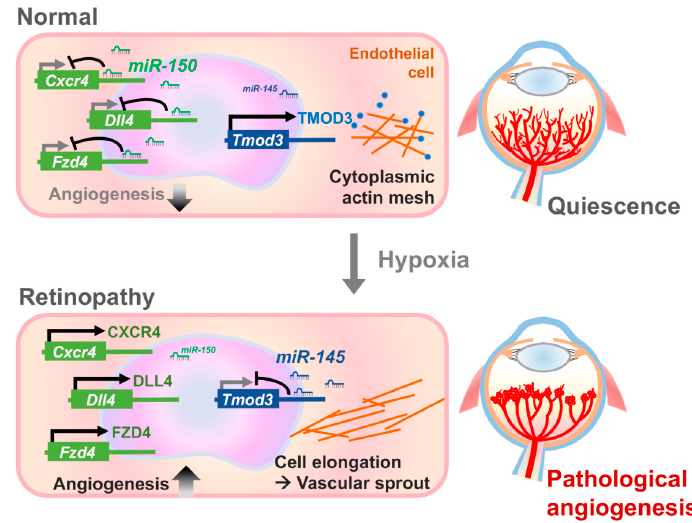
Figure 3. Targeting miR-150 and miR-145 in experimental retinopathy. This illustration uses miR-150 and miR-145 as the two examples to depict the effects of miRNAs on normal and pathological ocular angiogenesis. In normal retinal vessels, the endothelial-enriched miR-150 suppresses expression of its downstream angiogenic genes, such as Cxcr4 , Dll4, and Fzd4 , resulting in reduced angiogenic effects. On the other hand, normal endothelial cells have low levels of miR-145 , which induces target gene TMOD3, allowing its binding to the pointed end of acting filaments, stabilizing the cytoplasmic actin mesh. High levels of miR-150 and low levels of miR-145 in normal retinal vessels both function to maintain quiescence of retinal vessels. On the other hand, in retinopathy, decreased expression levels of miR-150 in pathological neovessels results in upregulation of its angiogenic targets—CXCR4, DLL4, and FZD4, leading to increased angiogenesis and formation of pathologic neovascularization. Retinal hypoxia in the retinopathy condition also causes the upregulation of miR-145 , leading to repression of Tmod3 , releasing the capping of actin filaments. This alteration in actin dynamics and architecture leads to increased endothelial cell angiogenic function, and thereby enhanced pathological angiogenesis. Figure adapted from “ Endothelial microRNA-150 is an intrinsic suppressor of pathologic ocular neovascularization ” by Liu et al. 2015, PNAS, 112(39), p. 12163–12168 [169]; and “ MicroRNA-145 Regulates Pathological